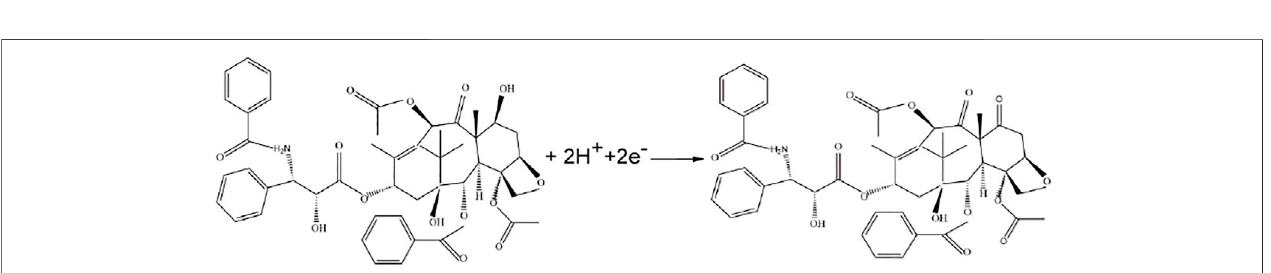
FIGURE 6 | Electrochemical mechanism of